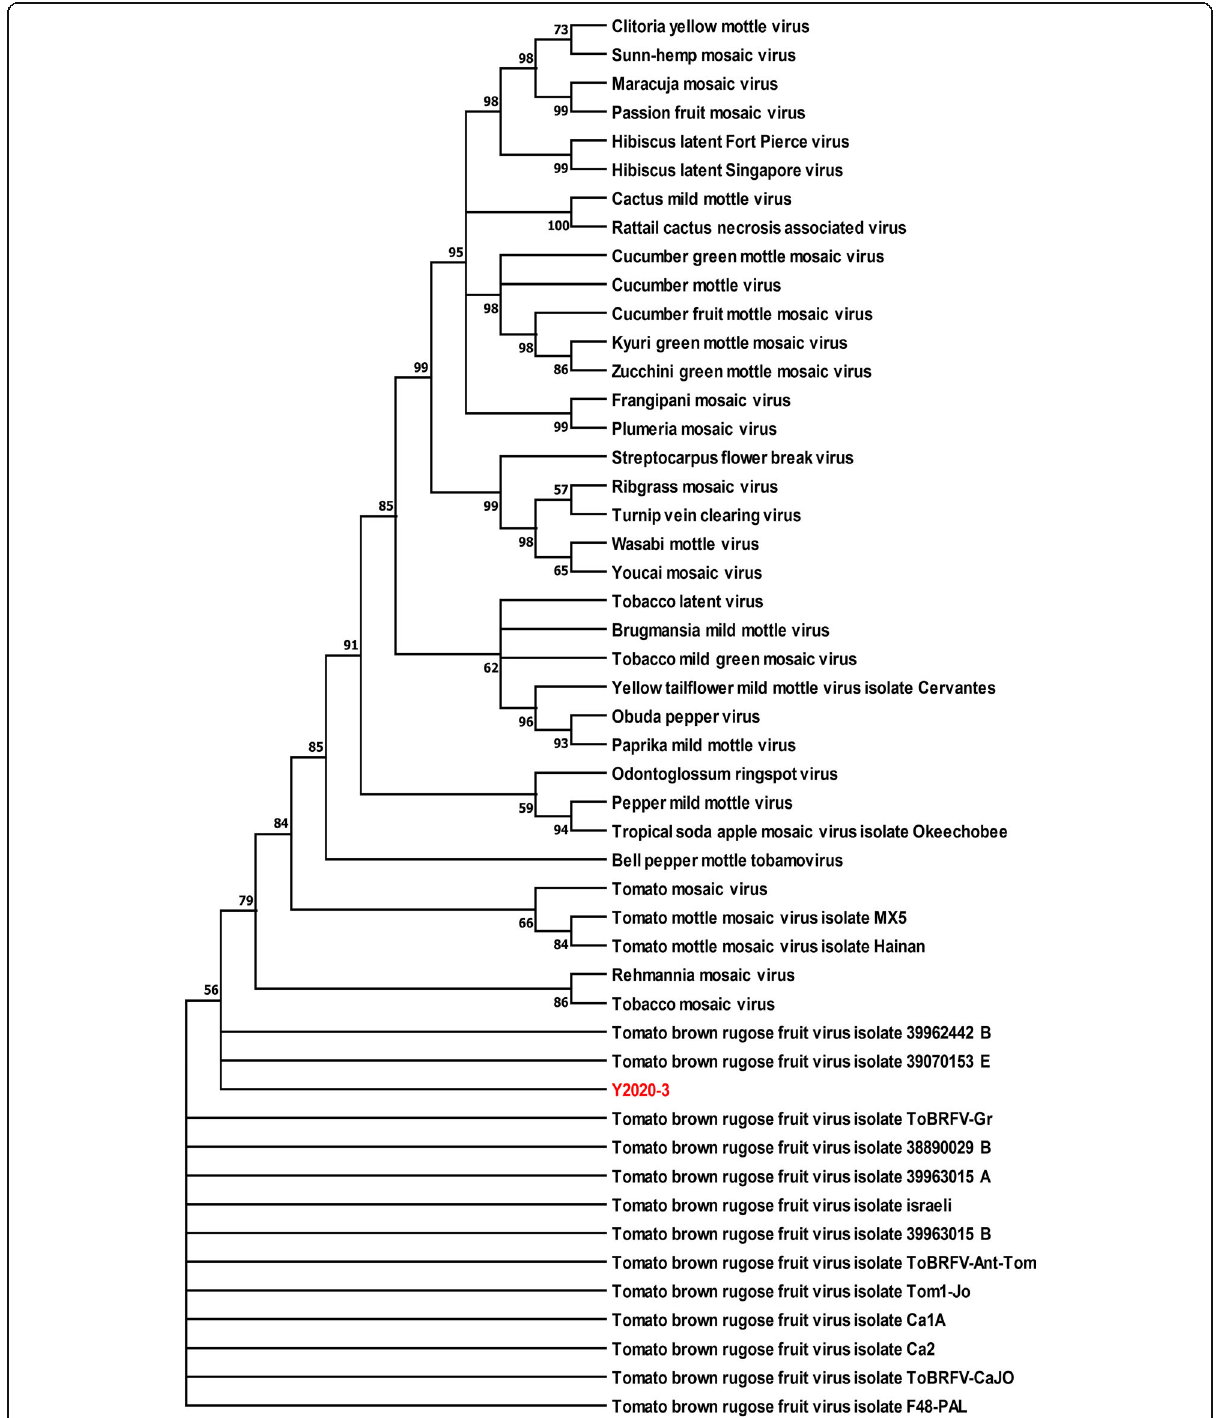
Fig. 3 Neighbor-joining phylogenetic tree constructed based on the complete genome sequences of ToBRFV and the representative tobamoviruses. The statistical significance of the branches was calculated by bootstrap with 1000 replicates. Branches with less than 50% bootstrap support have been